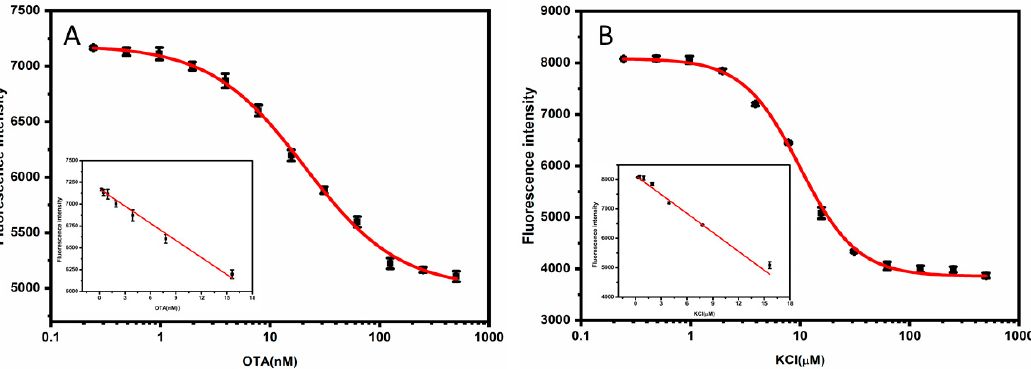
Figure 3. ( A ) Calibration curve for OTA. The inset shows the linear relationship between the fluo- rescence intensity and the concentration of the OTA ( B ) Calibration curve for K + . The inset shows the linear relationship between the fluorescence intensity and the concentration of K + . The error bar represents the standard deviations of the three parallel experiments.